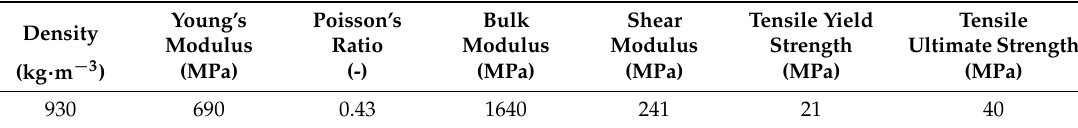
Table 1. UHMWPE GUR 1050 attributes.